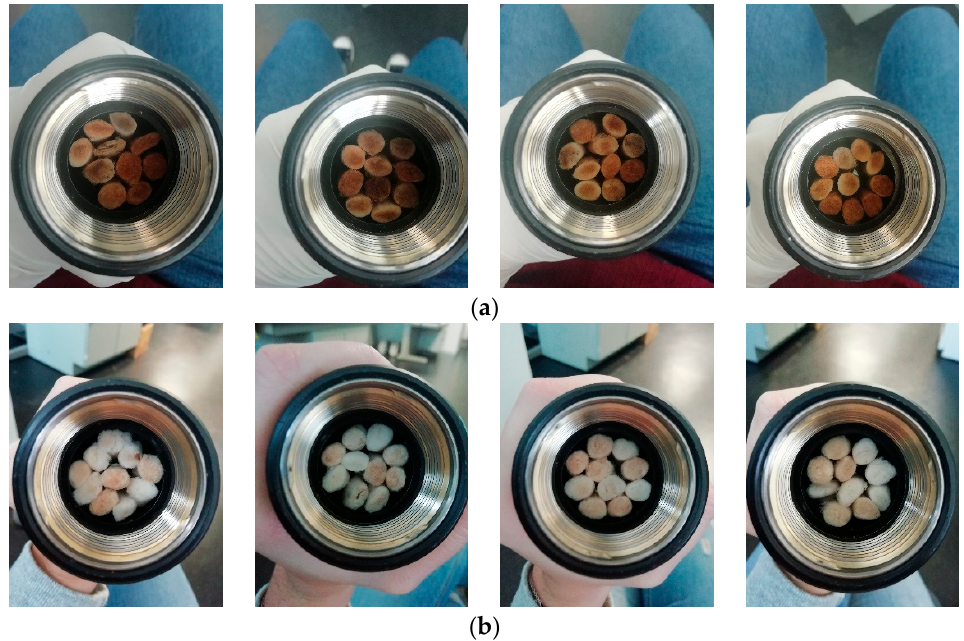
Figure 8. Effect of chemical cleaning on the appearance of the cigarette ( a ) before and ( b ) after